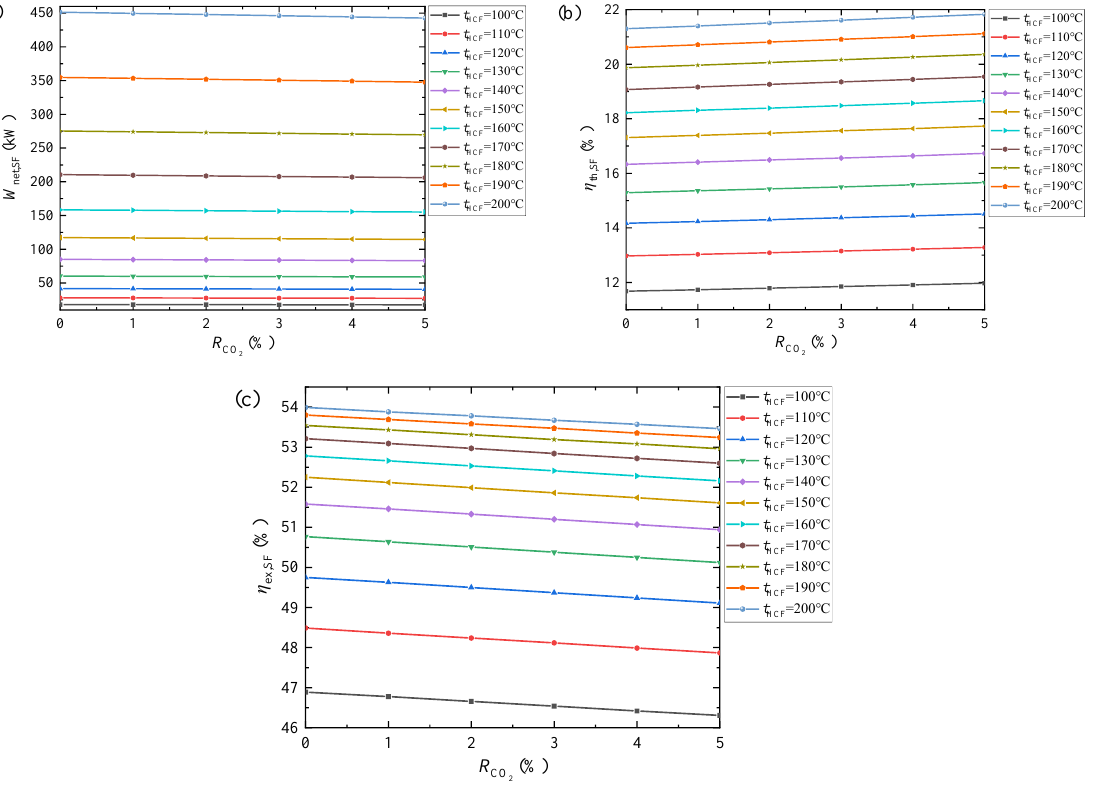
Figure 19. Variation of optimal thermodynamic parameters of the SF system with R CO2 at different heat carrier temperatures: ( a ) W net, SF , ( b ) η th, SF and ( c ) η ex, SF.